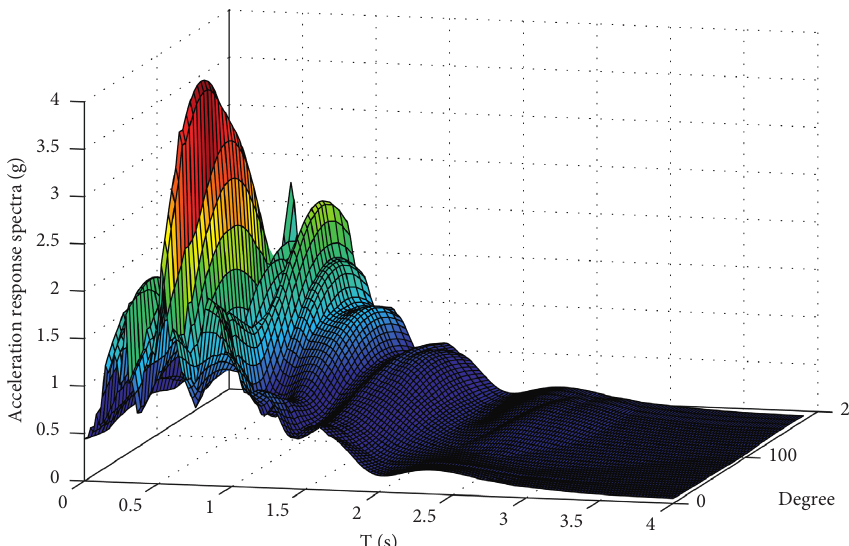
Figure 5: The acceleration response spectra of the horizontal components of the RSN953